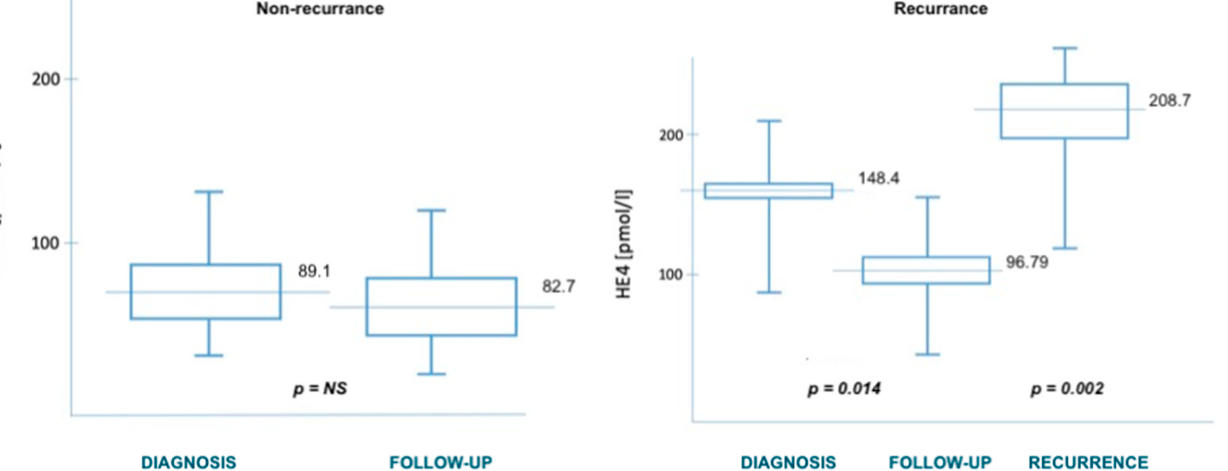
Figure 5. CA125 levels in relation to recurrence. Table 3. FIGO stage and recurrence. FIGO Stage